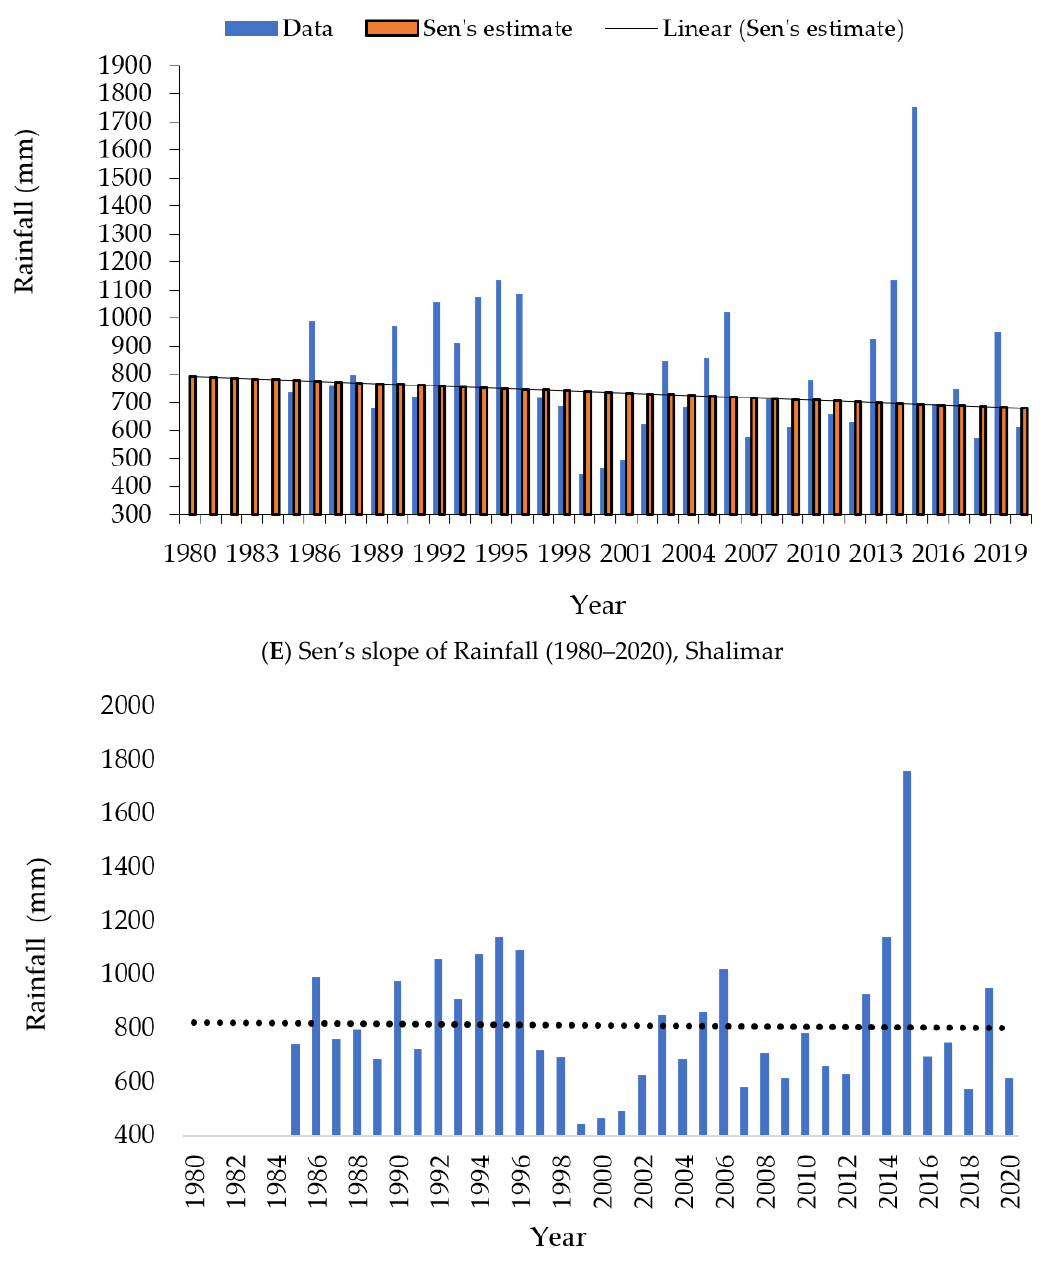
Figure 2. Descriptive statistics of weather parameters viz., Maximum and Minimum Temperature and Rainfall of location Shalimar